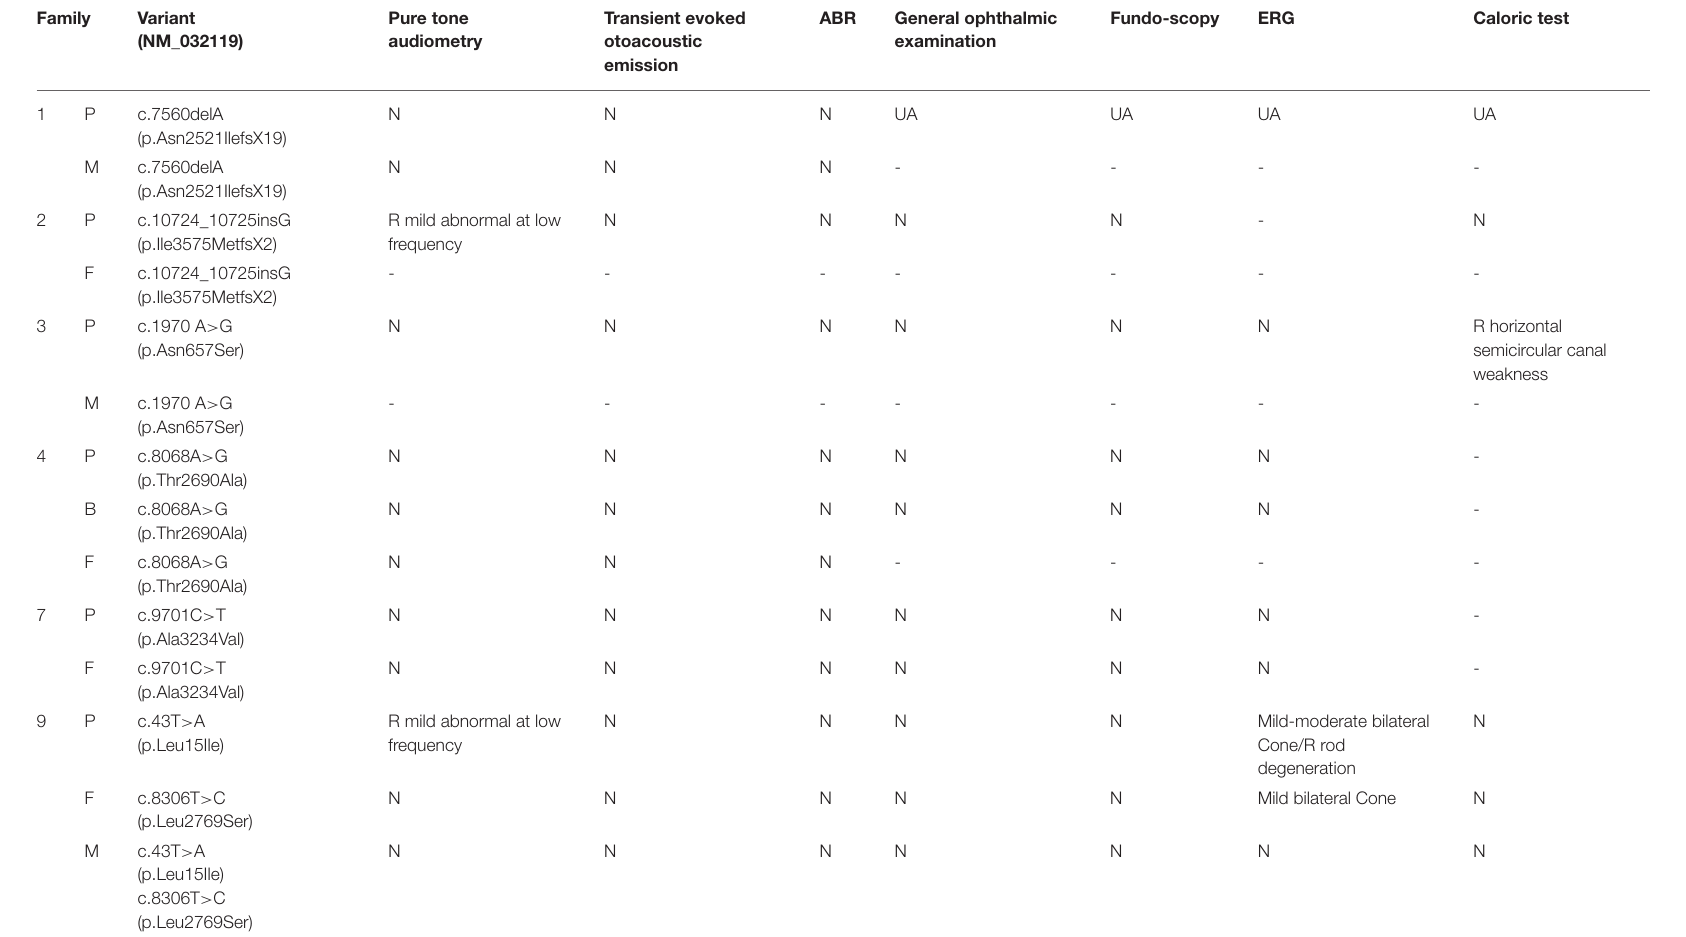
TABLE 3 | Audio-visual examination of six patients and their variant-carried parent(s).